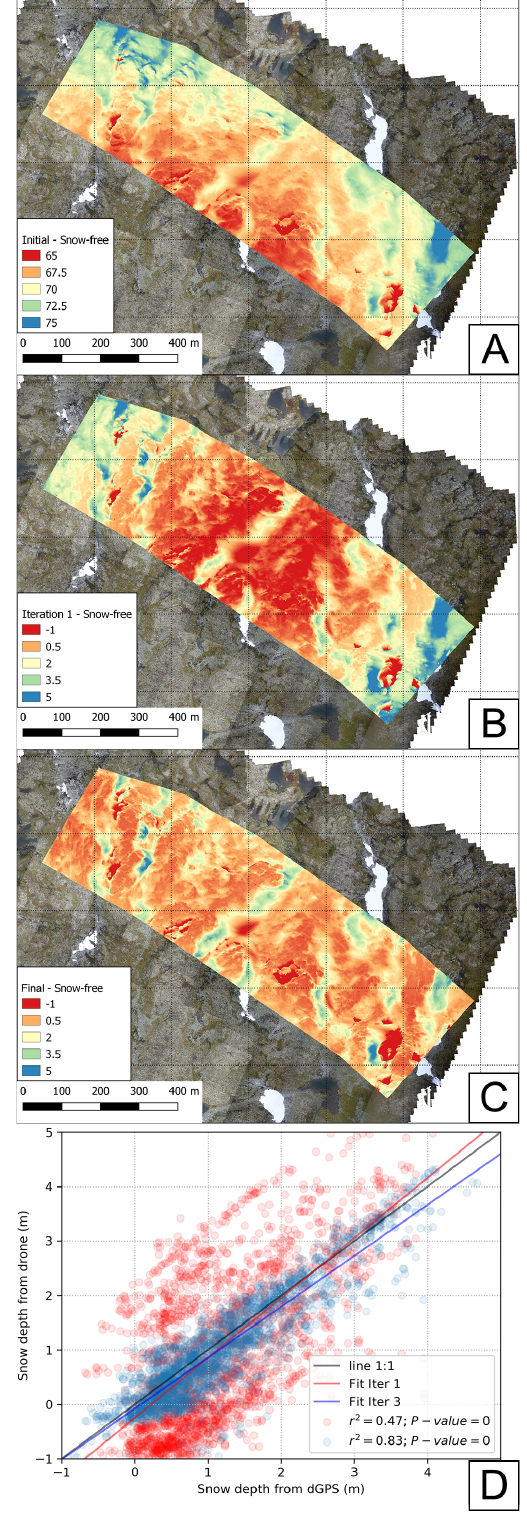
Figure 7. Snow depth maps according to the DEM computed at the different iterations (panels A, B, and C) and a scatter plot of the snow depth values from the dGPS track and the final drone map (D). Note the change of color-scale in between map (A) compare to (B) and (C). Linear regression fit are also indicated in